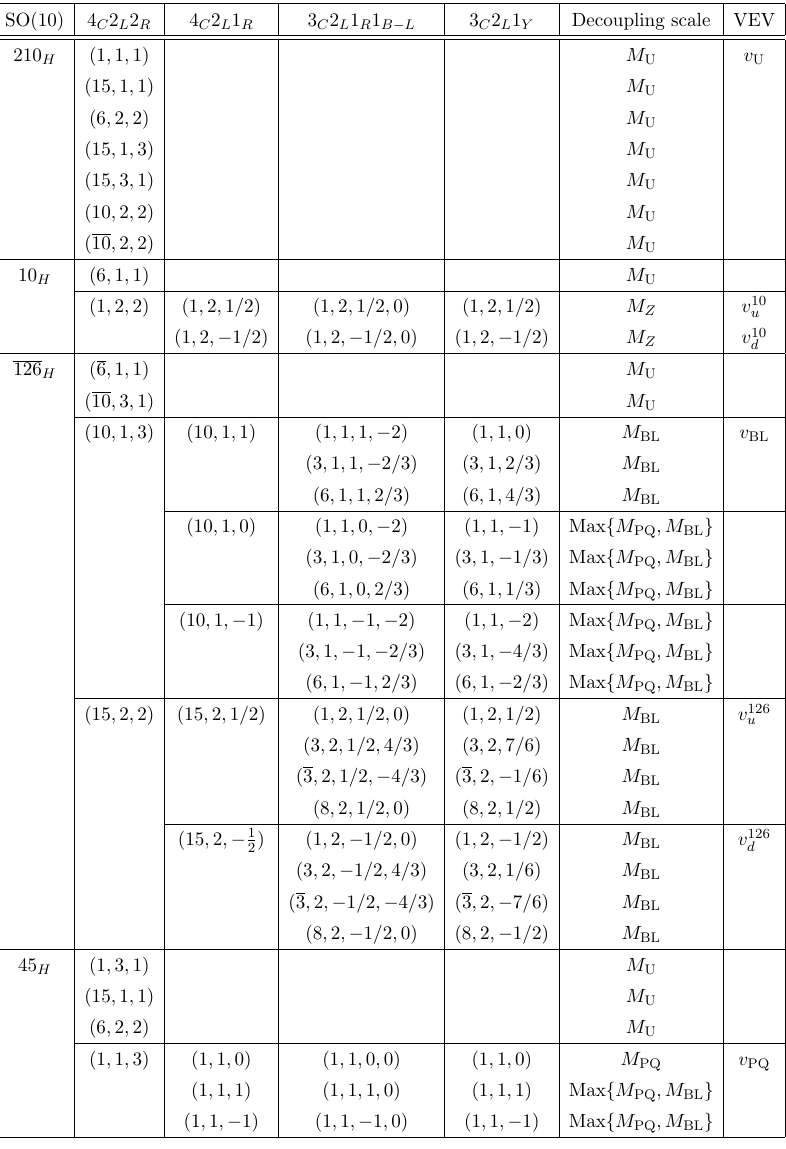
Table 7 . Decomposition of the scalar multiplets according to the various subgroups in our breaking chains. We list the scales at which the di(cid:11)erent representations decouple, and for a given represen- tation we don’t provide the decomposition under gauge groups that emerge below its decoupling scale, except for (cid:12)elds decoupling at M PQ (depending on the model, M PQ can lead to the breaking of the gauge group, or